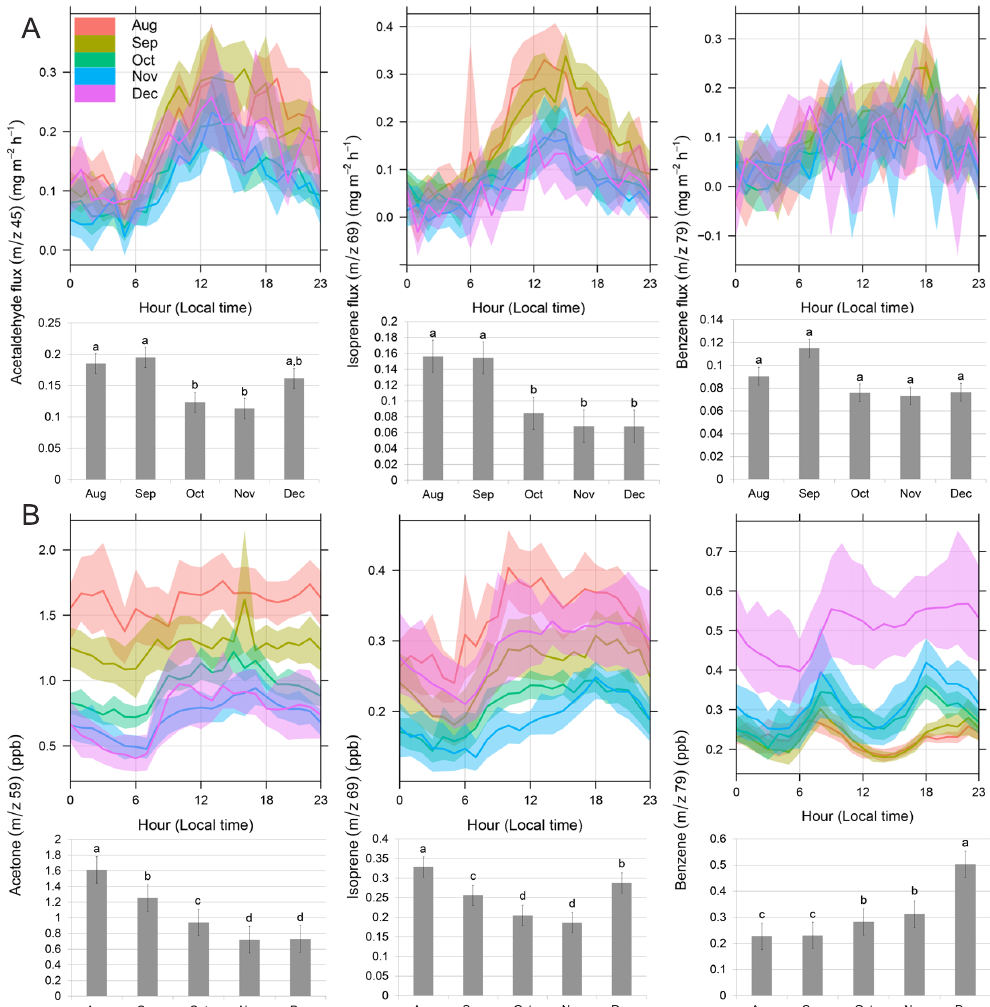
Figure 4. Diurnal profiles by month with confidence intervals and bar charts showing hourly averages for the respective month and repre- sentative compound (top) fluxes (mgm − 2 h − 1 ) ( m/z 45, 69 and 79) and (bottom) mixing ratios (ppb) ( m/z 59, 69 and 79). Letters (a–d) indicate statistically significant subgroups using Tukey’s Honestly Significant Difference post hoc